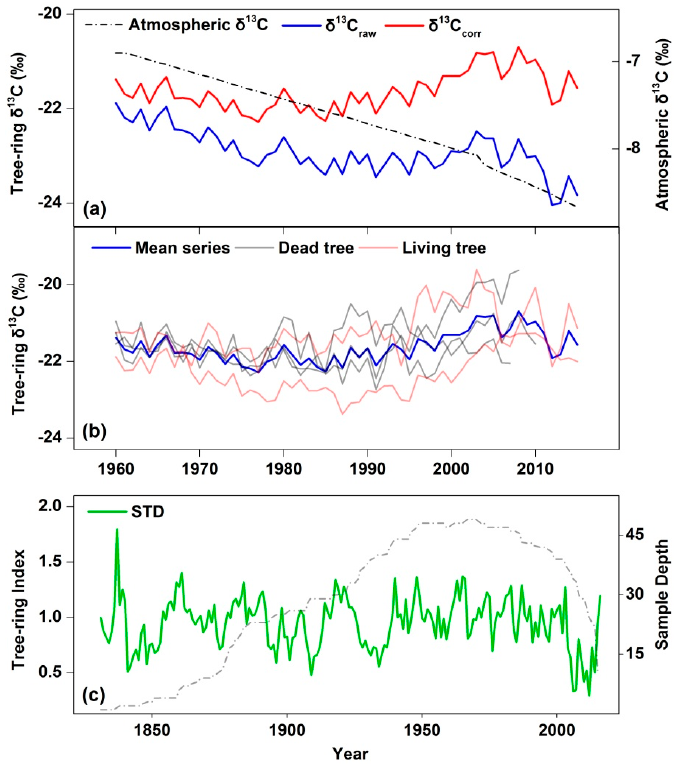
Figure 4. The temporal characteristics of δ 13 C chronology and growth chronology (STD). ( a ) δ 13 C corr series (red line), the δ 13 C raw series (blue line), and the atmospheric δ 13 C (dashed line) during 1960–2015; ( b ) individual series of dead trees (black lines) and living trees (red lines), and tree-ring δ 13 C chronology (blue line). ( c ) STD chronology (green line) and sample size (dotted line).